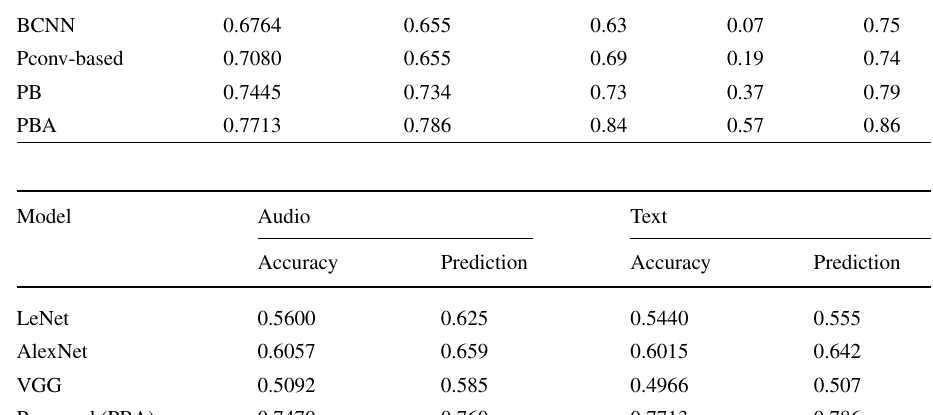
Table 3 The performance results of the text model with different methods